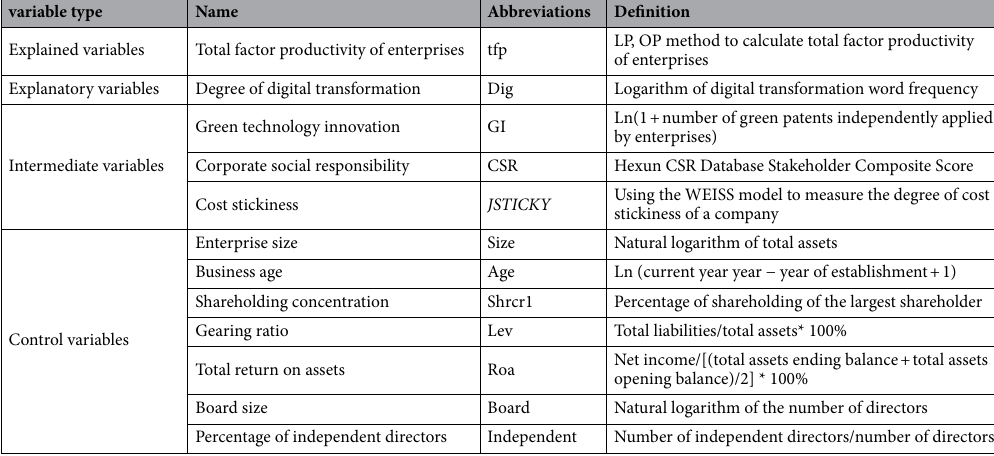
Table 1. Variable